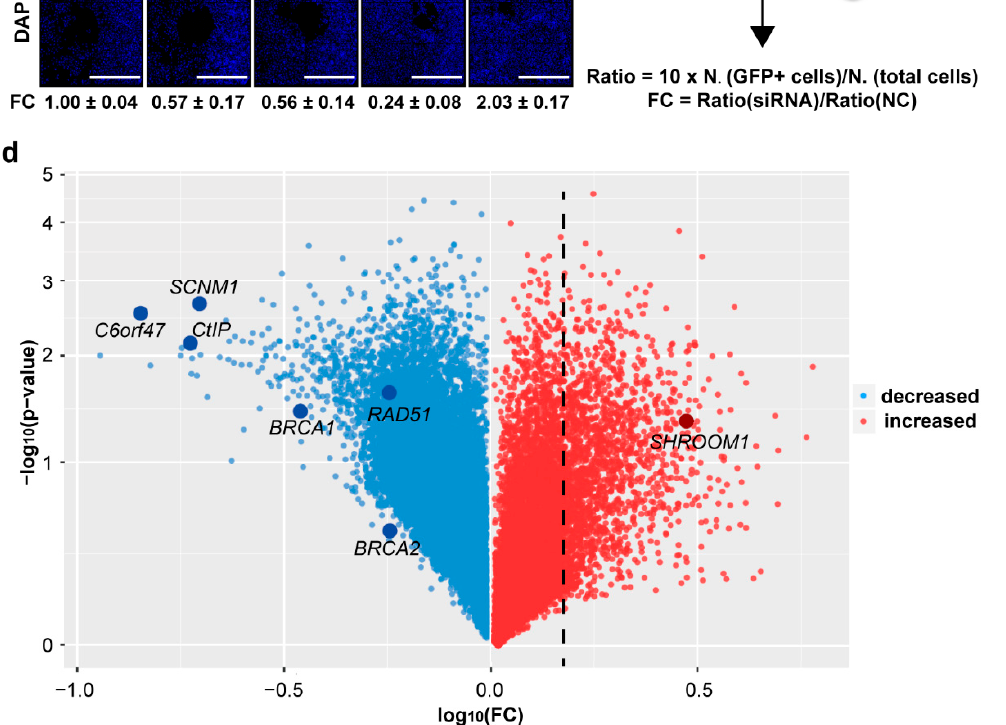
Figure 1. Genome-wide screening of HDR (homology directed repair)-modulated genes. ( a ) Schematic overview of the HDR progress in induced DR-GFP U2OS cells. Dox, doxycycline. ( b ) A flow diagram of the genome-wide screening using a high-content instrument. PC, positive control, BRCA2 and RAD51 ; NC, negative control. Scale bar, 1000 µ m. ( c ) Fluorescence pictures captured by a high-content instrument. FC, fold change. Every picture was stitched together from individual fields of vision. Scale bar, 1000 µ m. ( d ) Multiple HDR-increased and decreased genes in the genome-wide screening. Representative genes are highlighted in dark blue. FC (fold change) of genes on dashed line equals 1.5. Data were generated from n = 3 independent experiments. The p -value was calculated using a two-sided Student’s t- test.